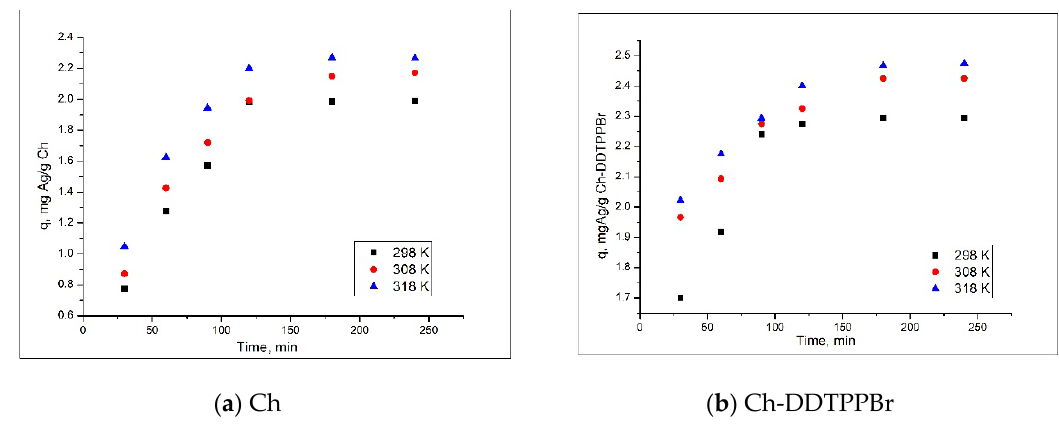
Figure 5. Contact time and temperature influence ( a ) Ch; ( b ) Ch-DDTPPBr.